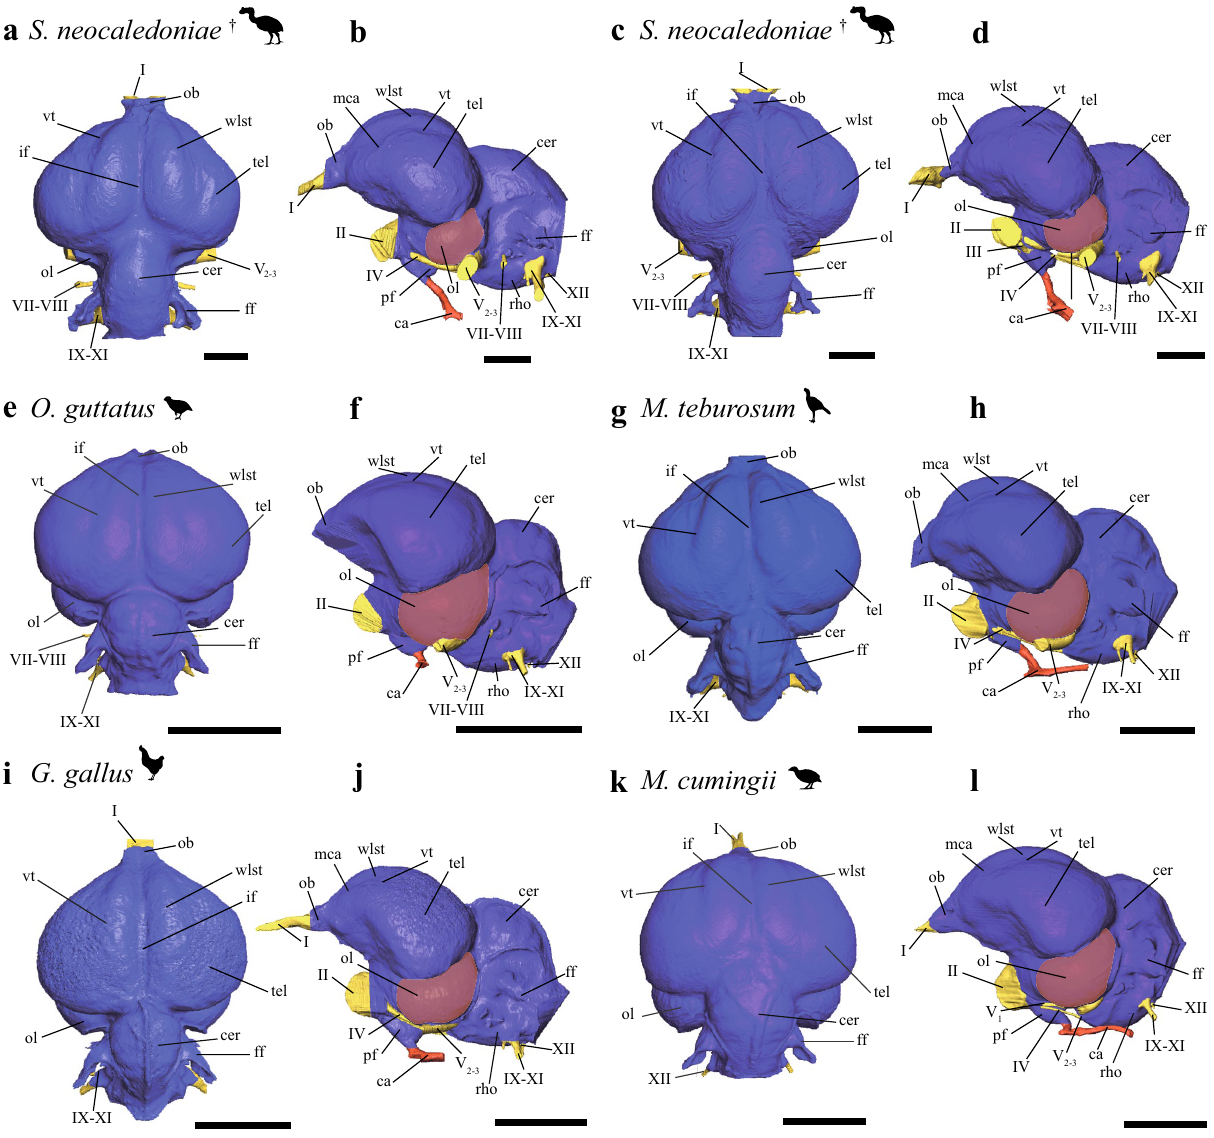
Figure 1. Digital endocranial reconstructions of Sylviornis neocaledoniae ( a , b , MNHN NCP 241; c , d , MNHN unnumbered), Odontophorus guttatus ( e , f ), Mitu tuberosum ( g , h ), Gallus gallus ( i , j ) and Megapodius cumingii ( k , l ). In dorsal ( a , c , e , g , i , k ) and left lateral ( b , d , f , h , j , l ) views. Optic lobes are highlighted in purple to aid in comparison of relative size of this structure across taxa. Colors: blue, endocast; yellow, cranial nerves; red, vasculature. ca carotid artery canal, cer cerebellum, ff floccular fossa, if interhemispheric, mca medial carotid artery canal, ob olfactory bulb, ol optic lobe, pf pituitary fossa, rho rhombencephalon, tel telencephalon, vt vallecula telencephali, wslt wulst, I olfactory nerve canal, II optic nerve canal, III oculomotor nerve canal, V 1 ophthalmic nerve canal, V 2–3 maxillomandibular nerve canal, VI abducens nerve canal, VII–VIII facial and vestibulocochlear nerves canal, IX–XI glossopharyngeal nerve canal and accessory nerves, XII hypoglossal nerve canal. † Fossil taxon. Scale bars = 1